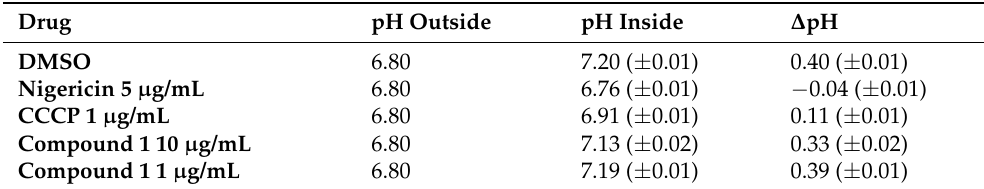
Table 5. pH outside refers to pH of external buffer. pH inside is the intracellular pH obtained using the BCECF-AN dye. Measurements of the fluorescence ratio ( λ ex 488 nm/ λ ex 440 nm) of BCECF were averaged (triplicates) and calibrated against a standard curve.